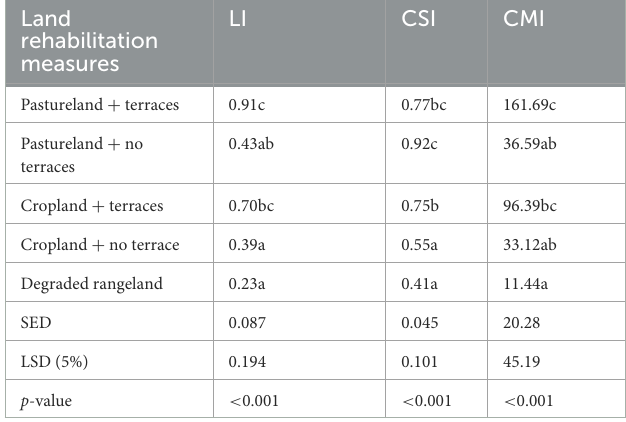
TABLE 2 Influence of terrace practice on carbon management index (CMI), lability index (LI), and carbon stock index (CSI) across soil conservation